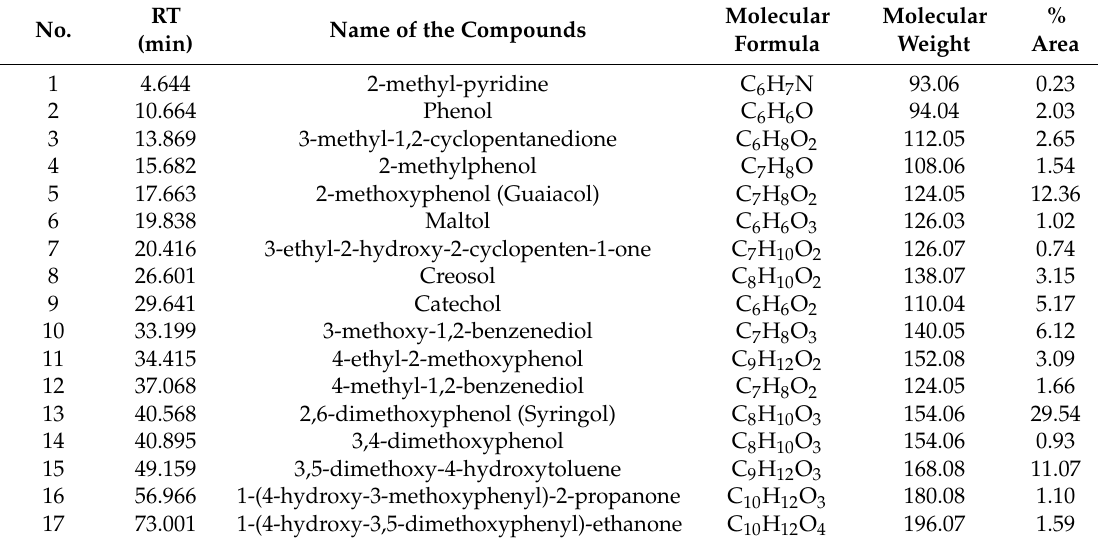
Figure 3. Molecular structures of lignin units.